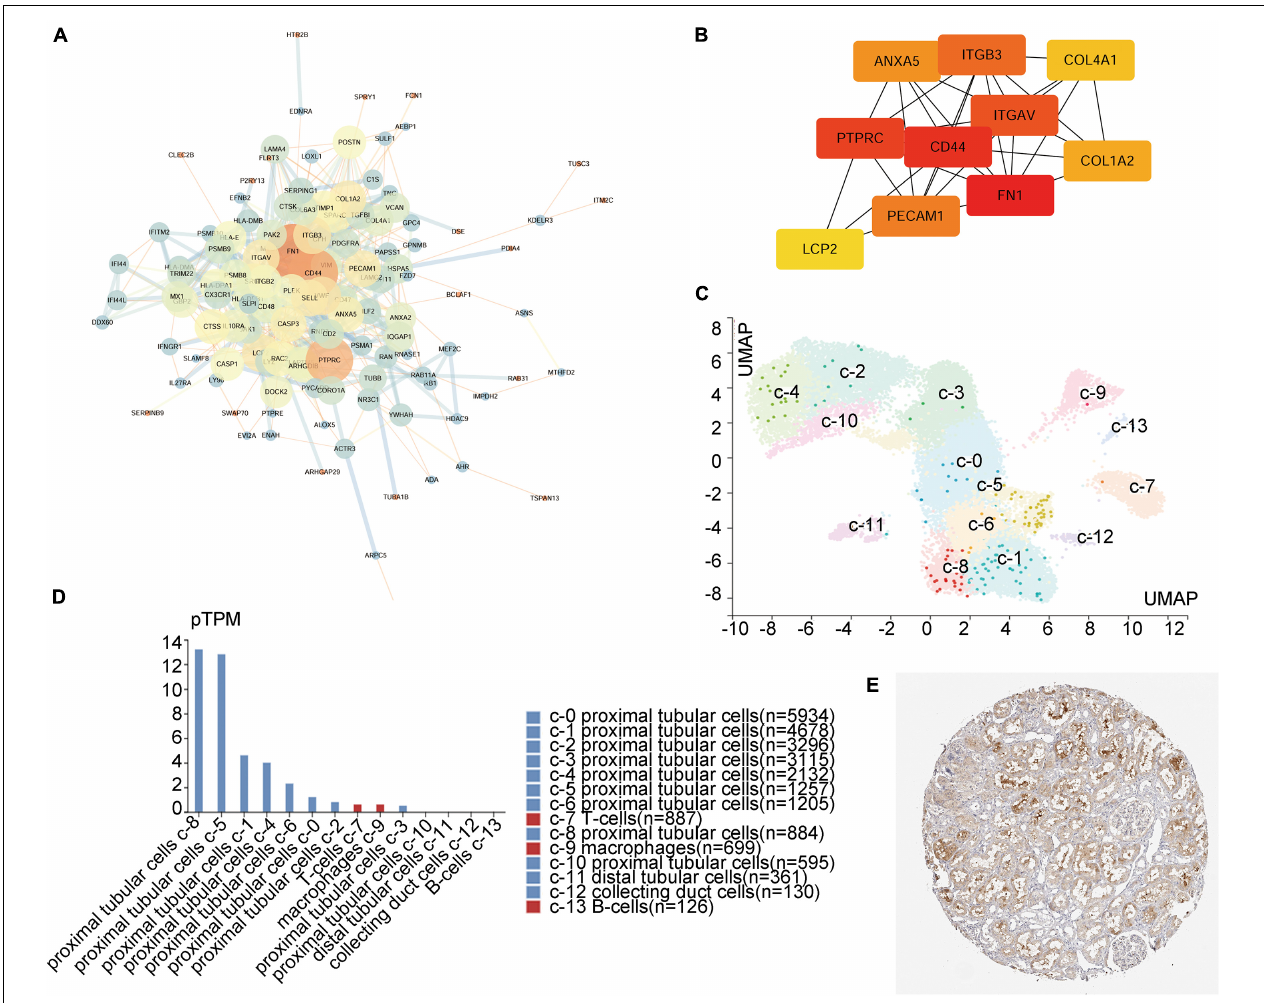
FIGURE 2 | Integrin β 3 (ITGB3) is the hub gene in CKD. (A) Entire PPI network analysis and (B) hub-gene identification of the DEGs. (C) Unsupervised scRNA-seq analysis distinguishing 14 different cell clusters in kidney cells from living donor based on the Human Protein Atlas Project. (D) Clusters and corresponding cell counts of scRNA-seq. (E) ITGB3 mainly expressed on renal